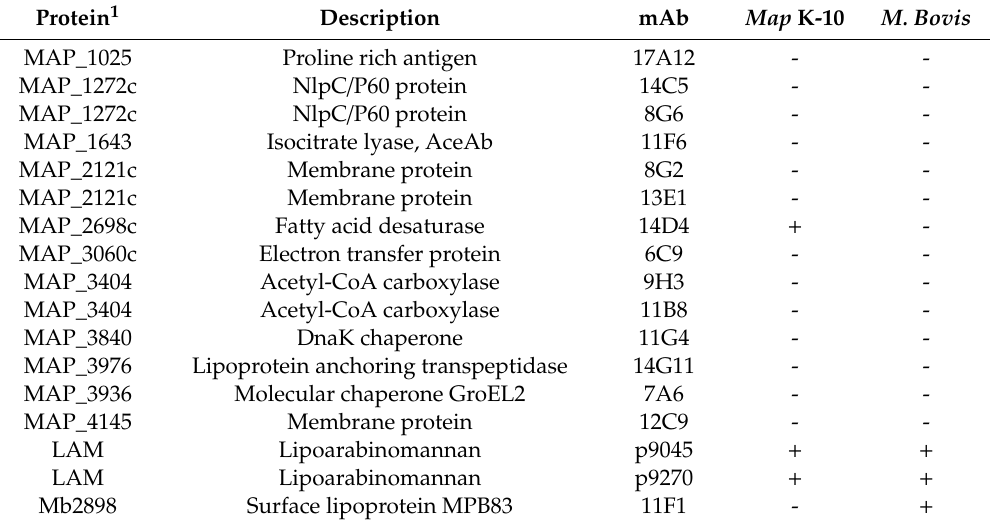
Table 2. Proteins present or absent in the Map and M. bovis EtOH extracts.